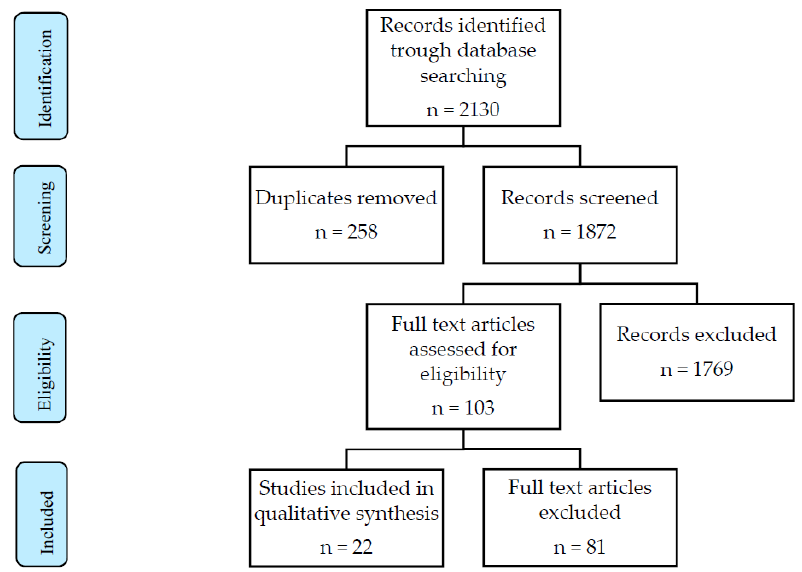
Figure 1. PRISMA flow diagram .